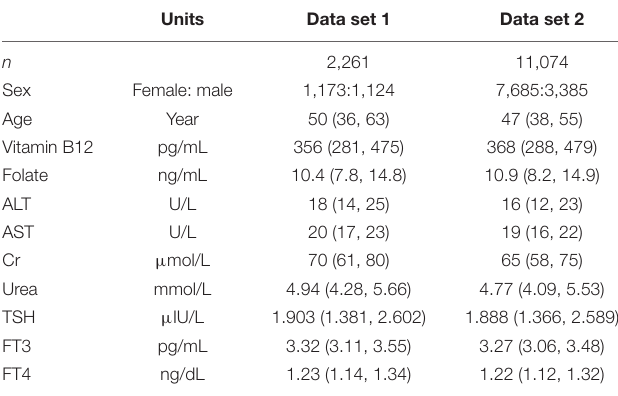
TABLE 1 | The basic information of data set 1 and data set 2.